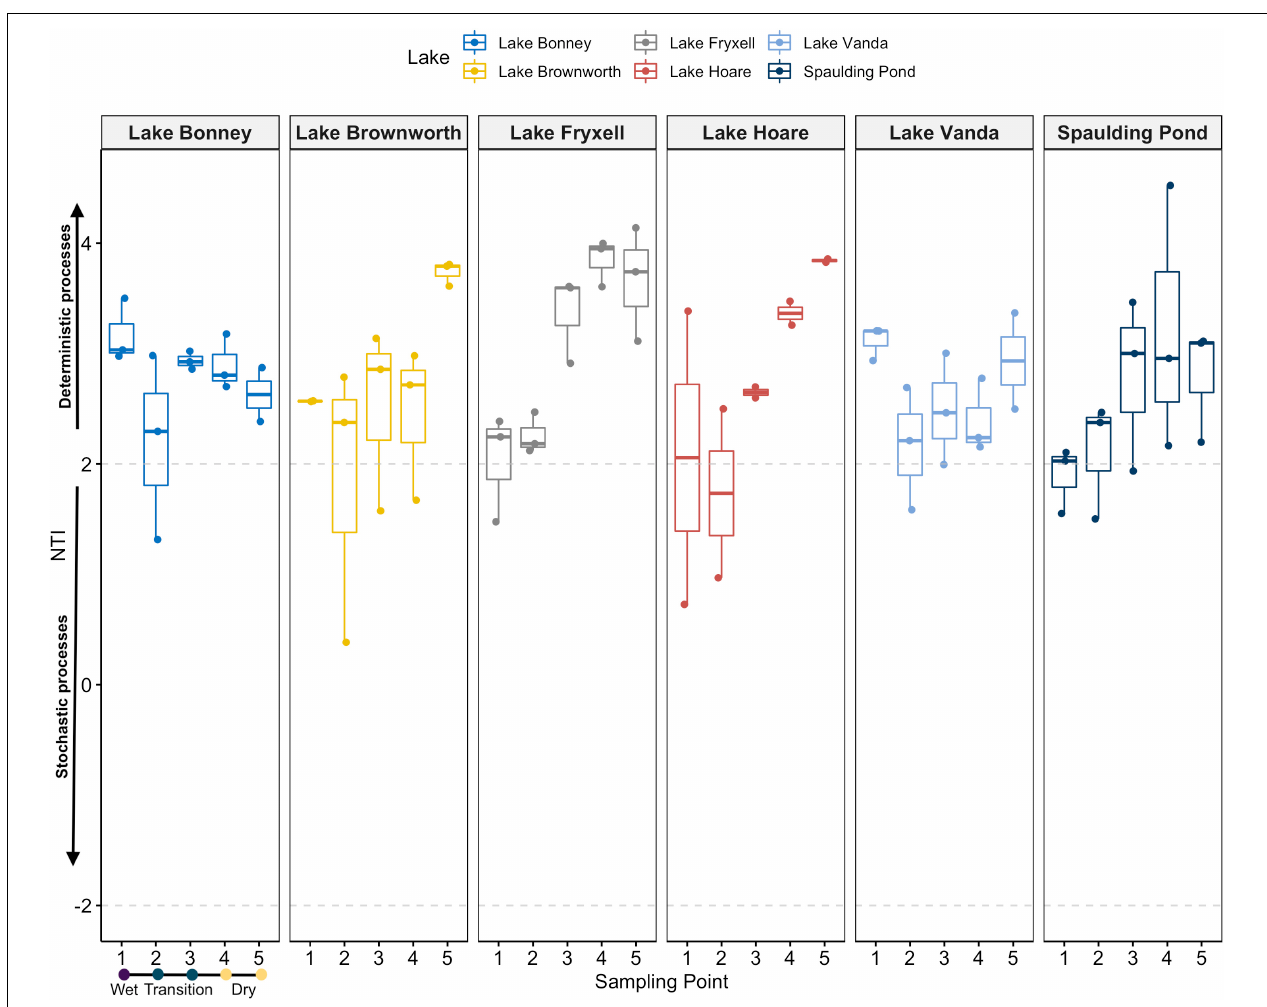
FIGURE 6 | NTI values for each single community sampled along space-for-time transects at each lake. Dashed gray lines at the − 2 and + 2 values delimitate the significance thresholds from the null expectation. NTI values < − 2 or > + 2 suggests that phylogenetic turnover is less or greater than the null expectation, and it is related to deterministic processes. NTI values ranging between –2 and 2 is usually considered signifying the influence of stochastic assembly.